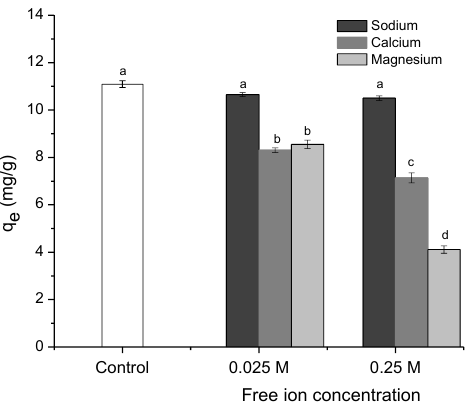
Figure 8. The effect of solution ion strength on the sorption of enrofloxacin onto the P. koidzumii sorbent (adsorbent dose 8 g/L; 100 mg ENR/L; contact time 40 min; pH 7; and temperature 298 K). Those means that do not share a common superscript differ significantly (Tukey p < 0.05).